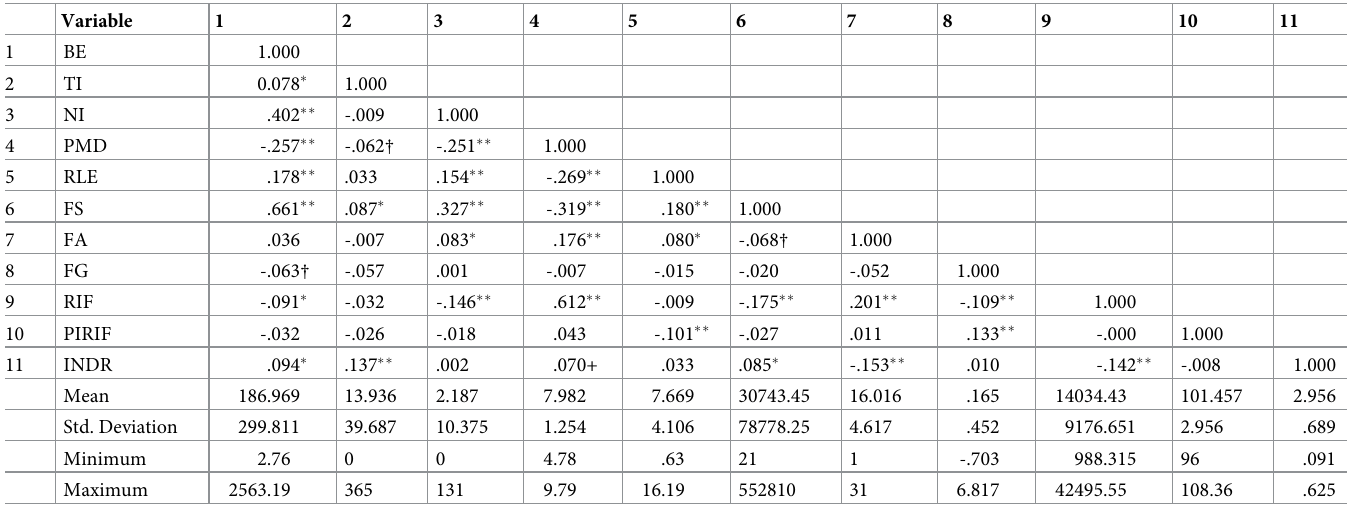
Table 3. Descriptive statistics and